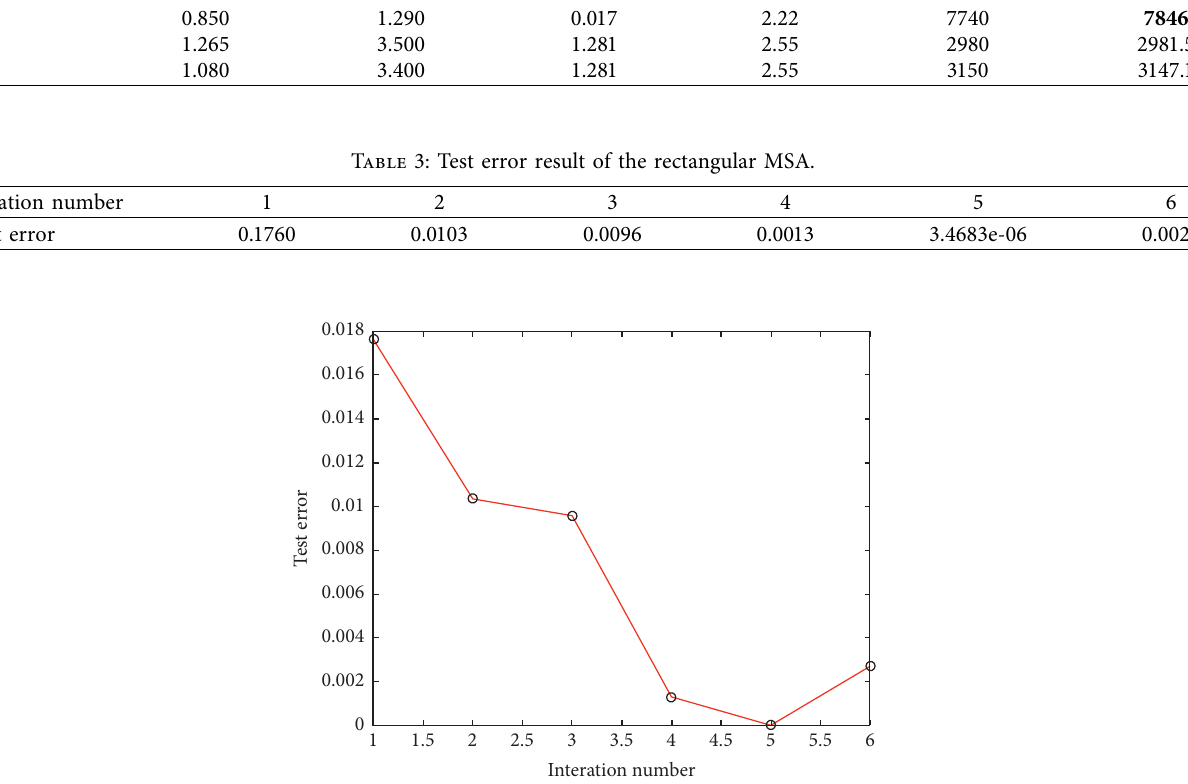
Table 2: Resonant frequency of the rectangular MSA in TM